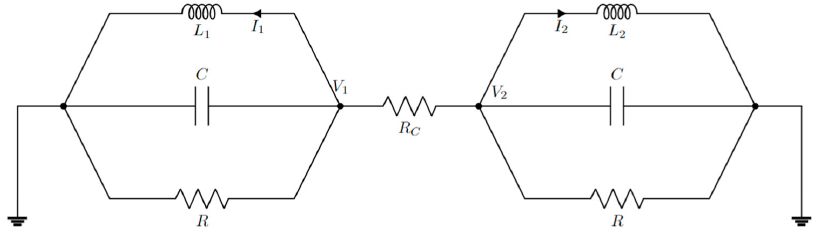
Figure 12. Anti-PT-symmetric electronic configuration realized with two coupled RLC resonators (architecture proposed in [76]).